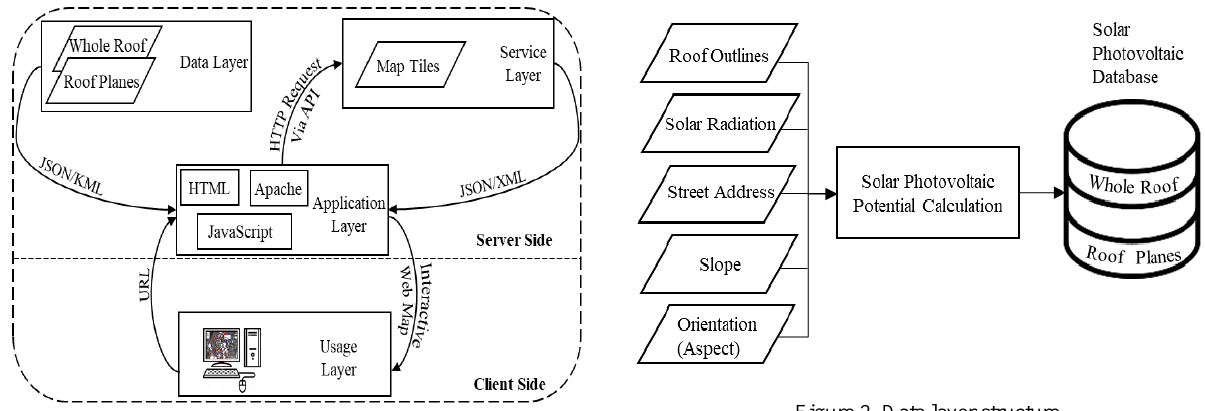
Figure 2. Data layer